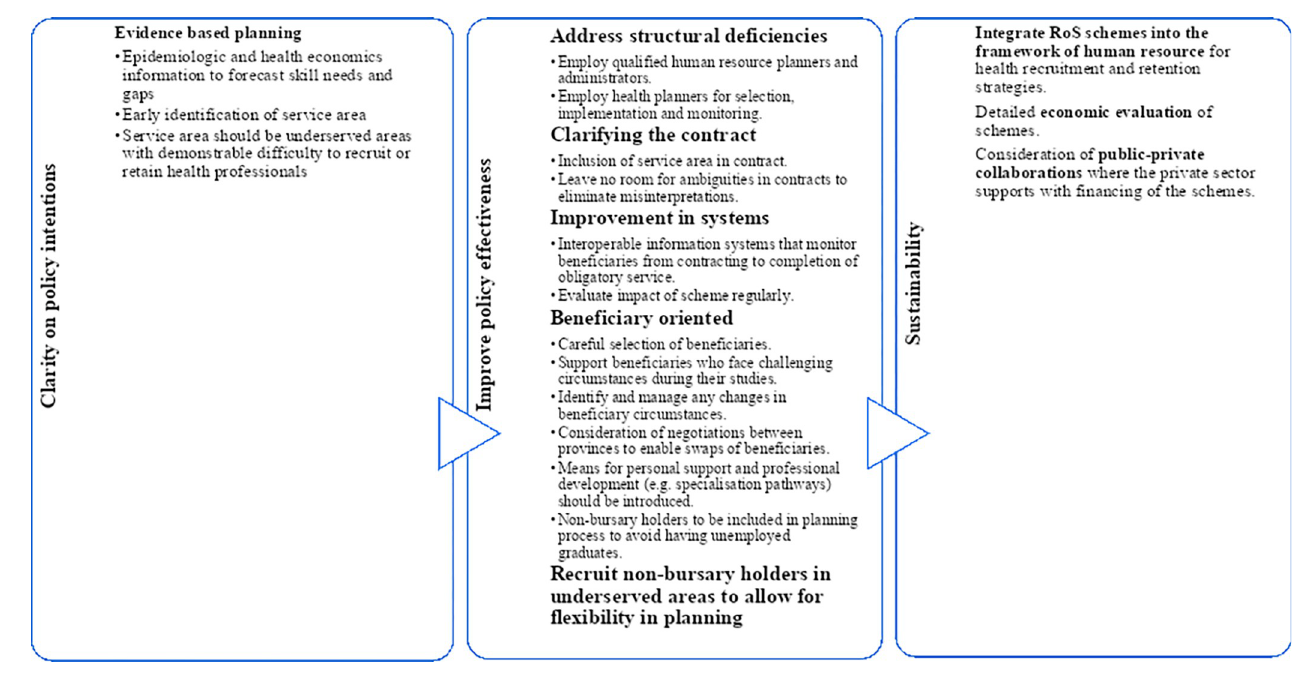
Fig 1. Policy implications for return-of-service